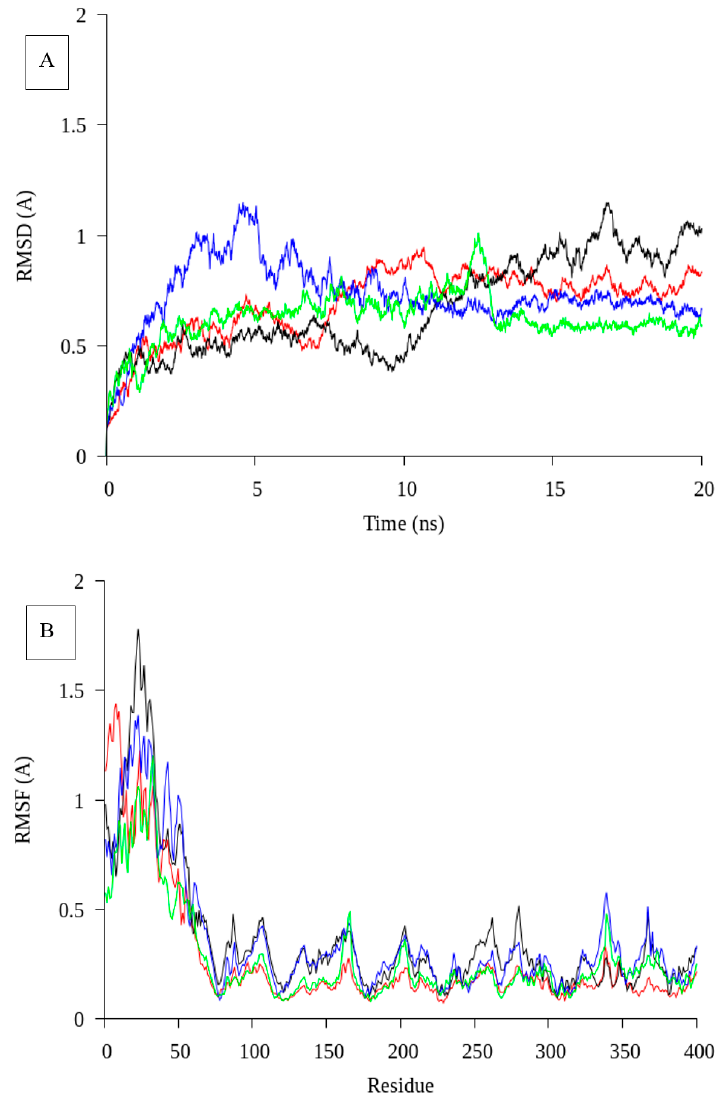
Figure 2. Molecular dynamic simulation of native at varies temperature. ( A ): RMSD value for AMS3 lipase in 20 ns; ( B ): RMSF value for AMS3 lipase in 20 ns. The red line represents a temperature of 10 °C; the Black line was 20 °C; Green was 30 °C; and Blue was 40 °C.